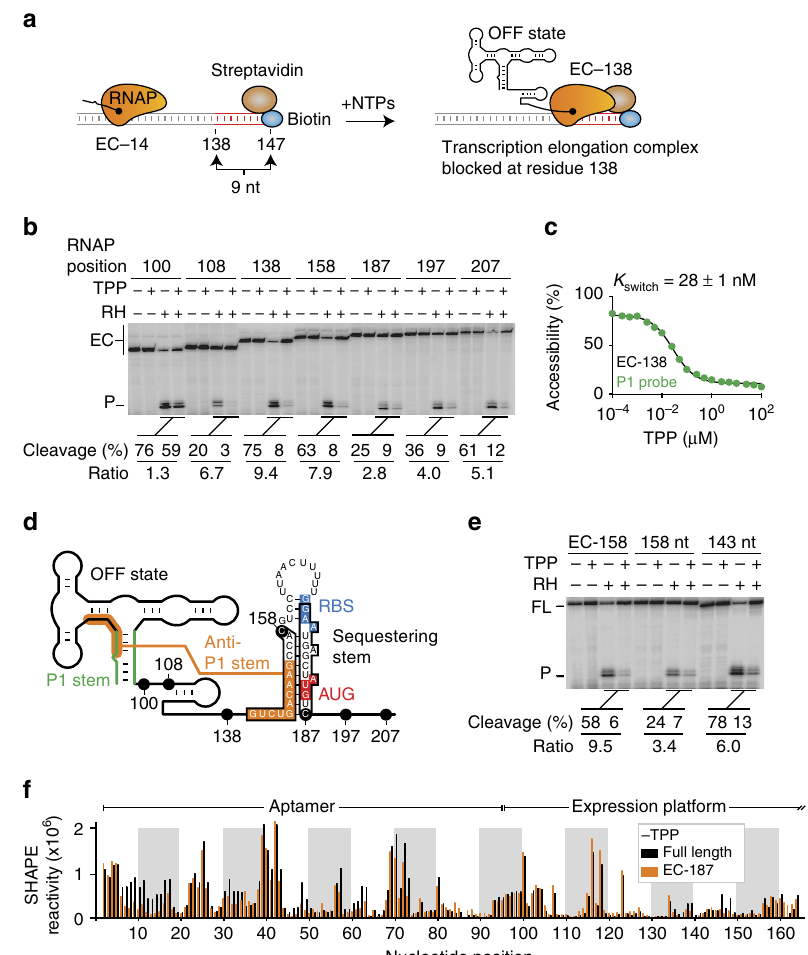
Figure 4 | The TPP-binding efficiency is modulated along the thiC riboswitch transcriptional pathway. ( a ) Schematic of the experimental system for the formation of elongation complexes (ECs) at position 138 (EC-138). Transcription initiation performed using a subset of NTP leads RNAP to stall at position 14 (EC-14). Using a DNA template containing a biotin–streptavidin complex, the addition of all four NTP results in RNAP to block at nine residues upstream from the end of the template, thus producing stable EC-138 complexes. ( b ) RNase H probing assays performed on thiC riboswitch ECs. Reactions were done in absence ( (cid:2) ) or presence ( þ ) of 10 m M TPP and in the absence ( (cid:2) ) or presence ( þ ) of RNase H (RH). Uncleaved ECs and cleaved products (P) are indicated on the left. Cleavage efficiencies and ratios are indicated below. ( c ) K switch determination using the P1 probe for the EC-138 complex. Cleavage reactions were done with increasing TPP concentrations ranging from 100pM to 100 m M. A K switch value of 28nM ± 1nM was obtained using the P1 probe. The corresponding gel is shown in Supplementary Fig. 9a. Experiments were done in triplicate and the data shown are a representative result. ( d ) Schematic of the thiC riboswitch showing the different stalled RNAP positions. For pause sites C158 and C187, the predicted sequence